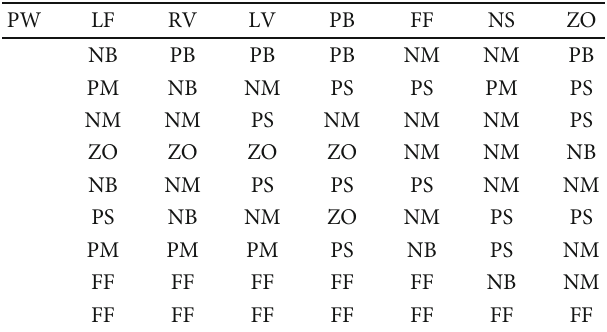
Figure 13: Track of social foraging swarms in a multiobstacle environment. Table 6: Fuzzy rules for promoting e ffi